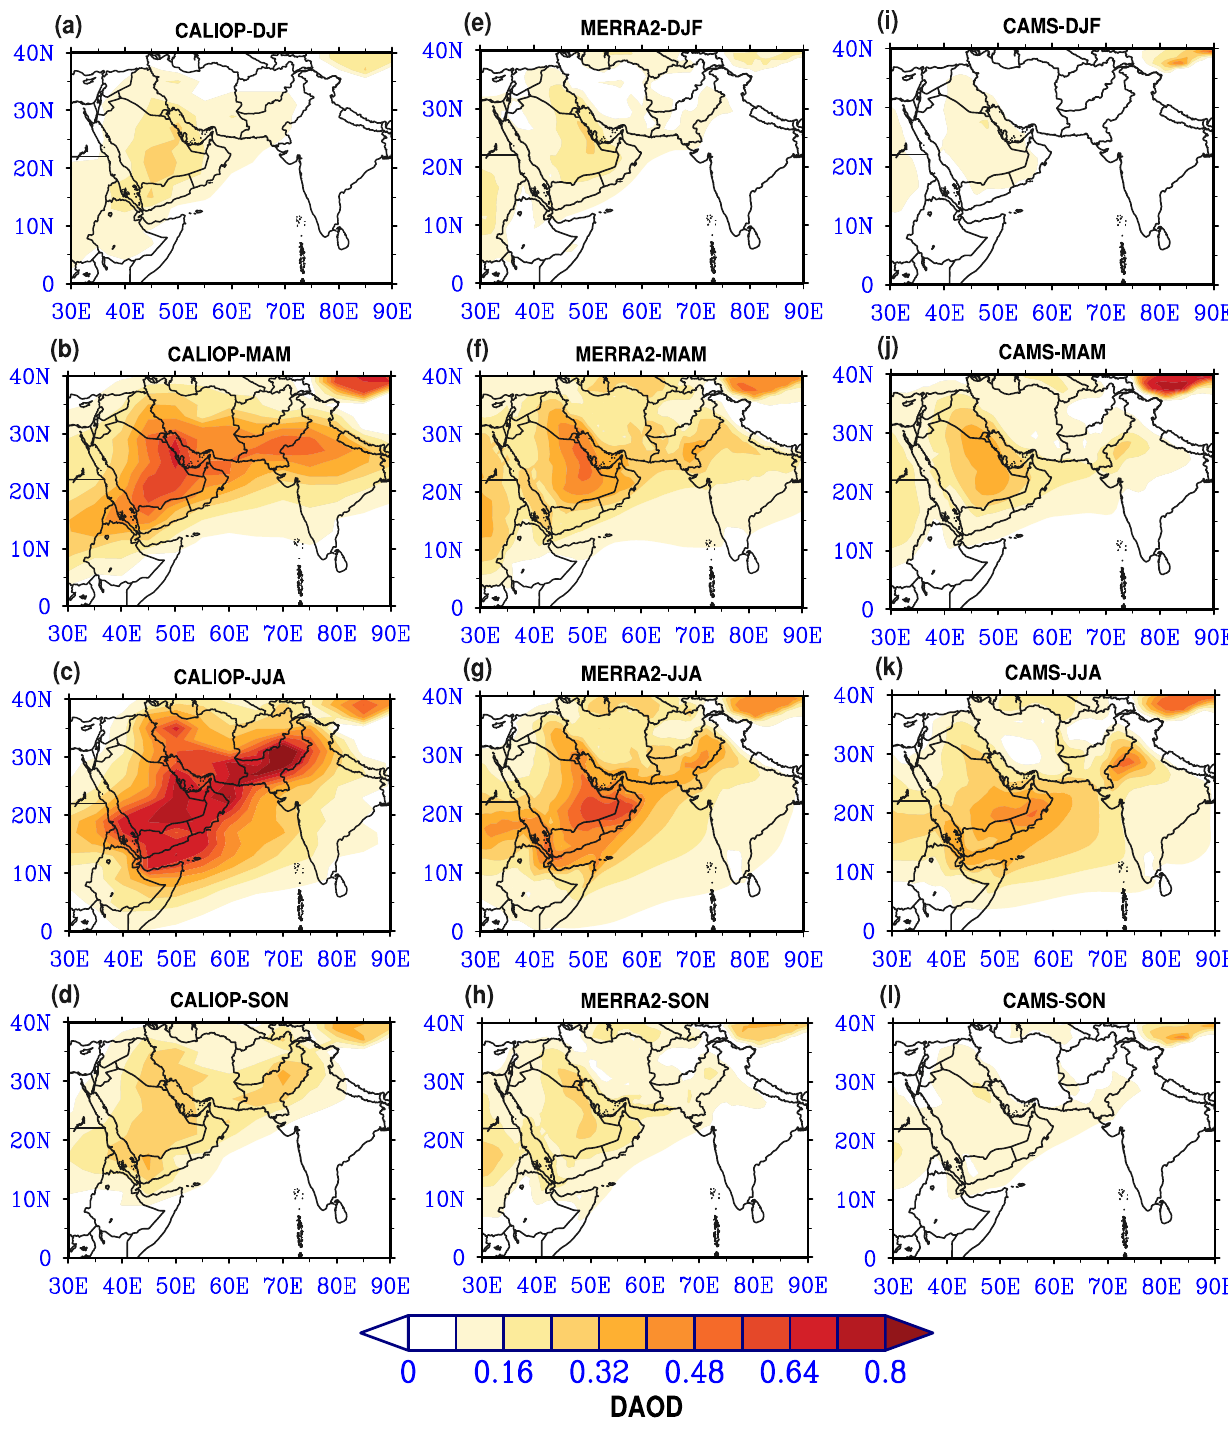
Fig. 2 Spatial distribution of dust aerosol optical depth. Seasonal climatology of Dust aerosol optical depth from CALIOP ( a – d ), MERRA-2 ( e – h ), and CAMS ( i – l ) over the period 2007 –